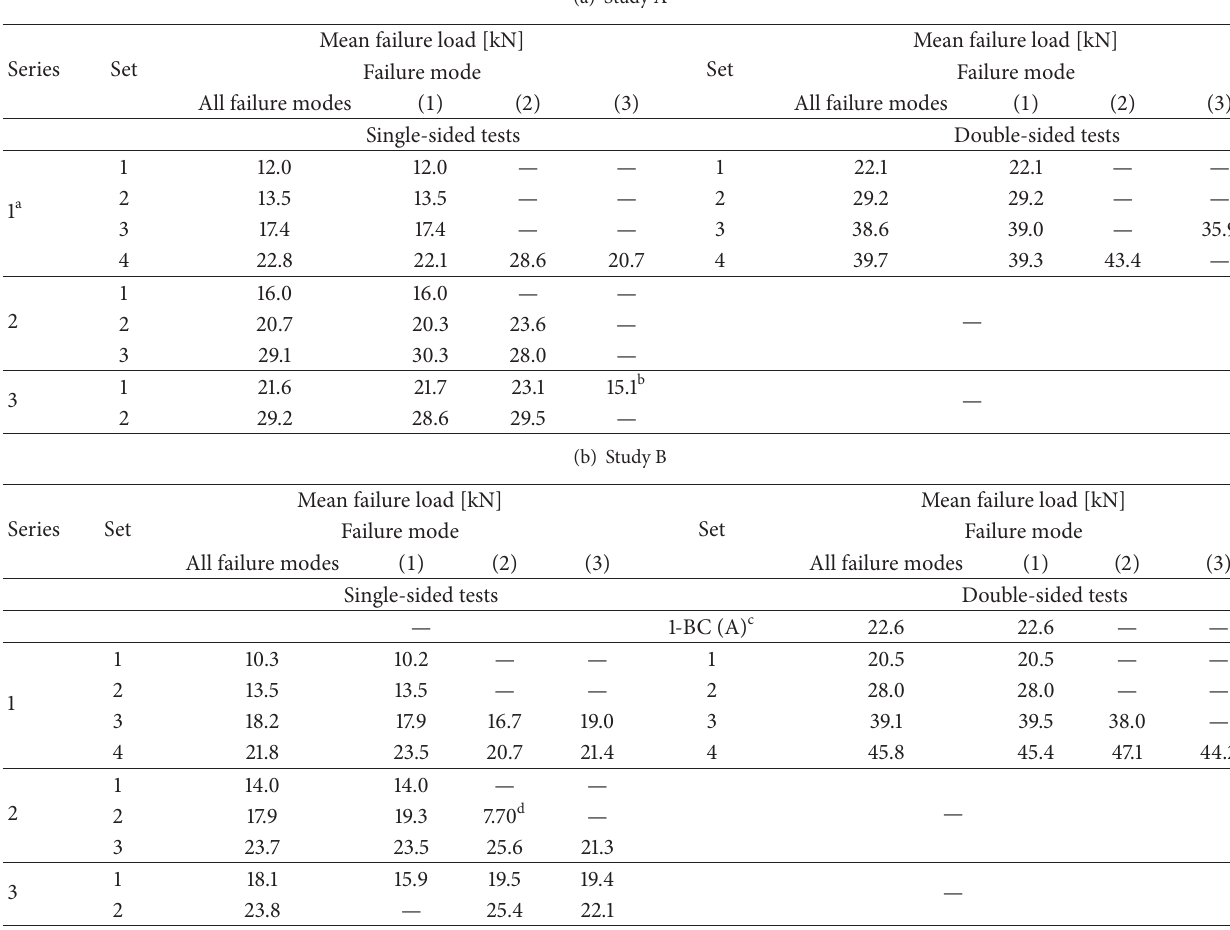
Table 3: Results from testing of specimens with the pith oriented downwards (PD). Failure modes are defined in Figure